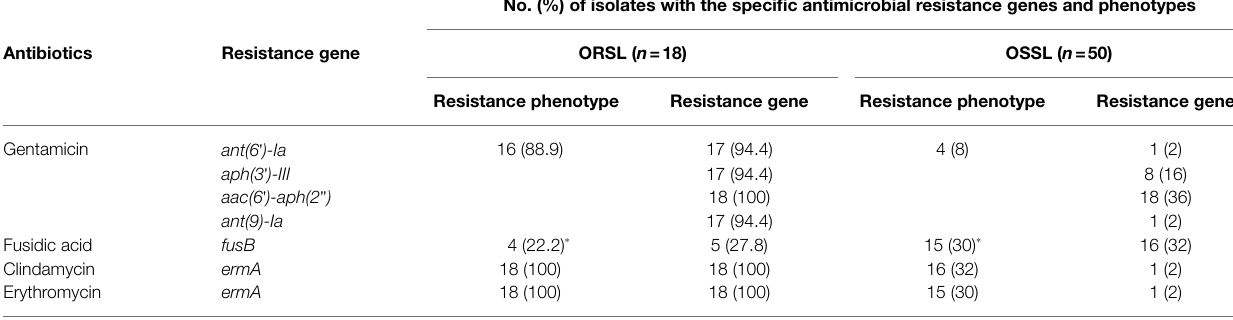
TABLE 4 | Prevalence of antibiotic resistance genes and phenotype among clinically collected ST6 strains.